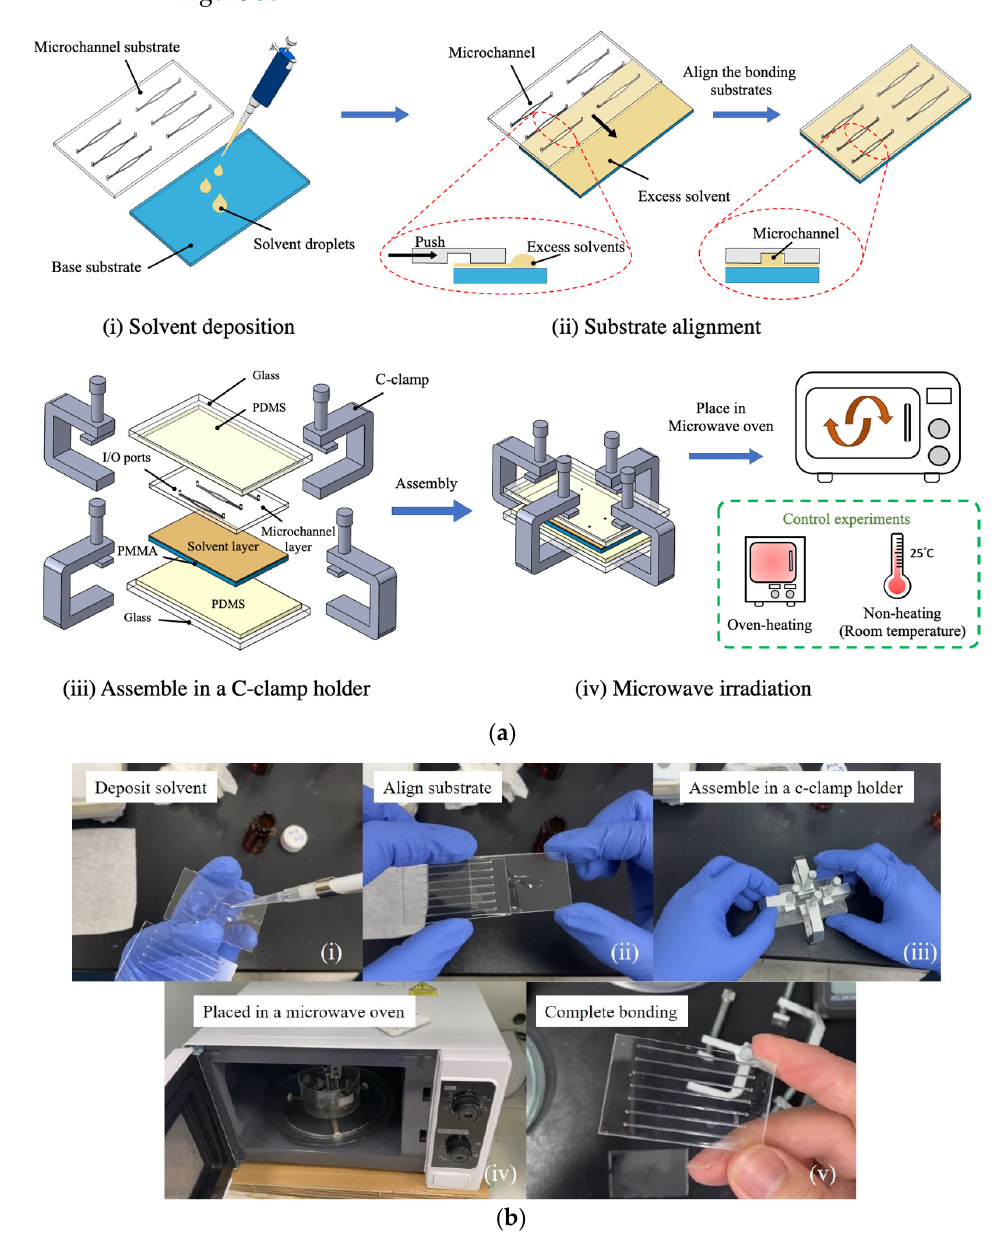
Figure 3. ( a ) Schematic illustration of microwave-assisted solvent bonding procedures, and ( b ) se- quential images of bonding procedure. ( b ) sequential images of bonding